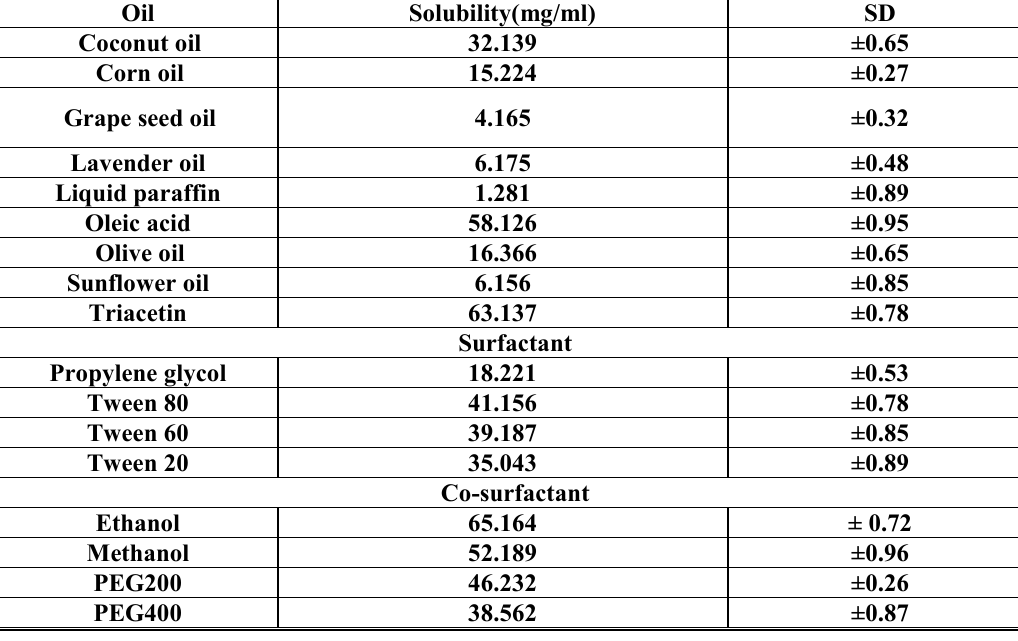
Table 2. Saturation solubility study of LCDP